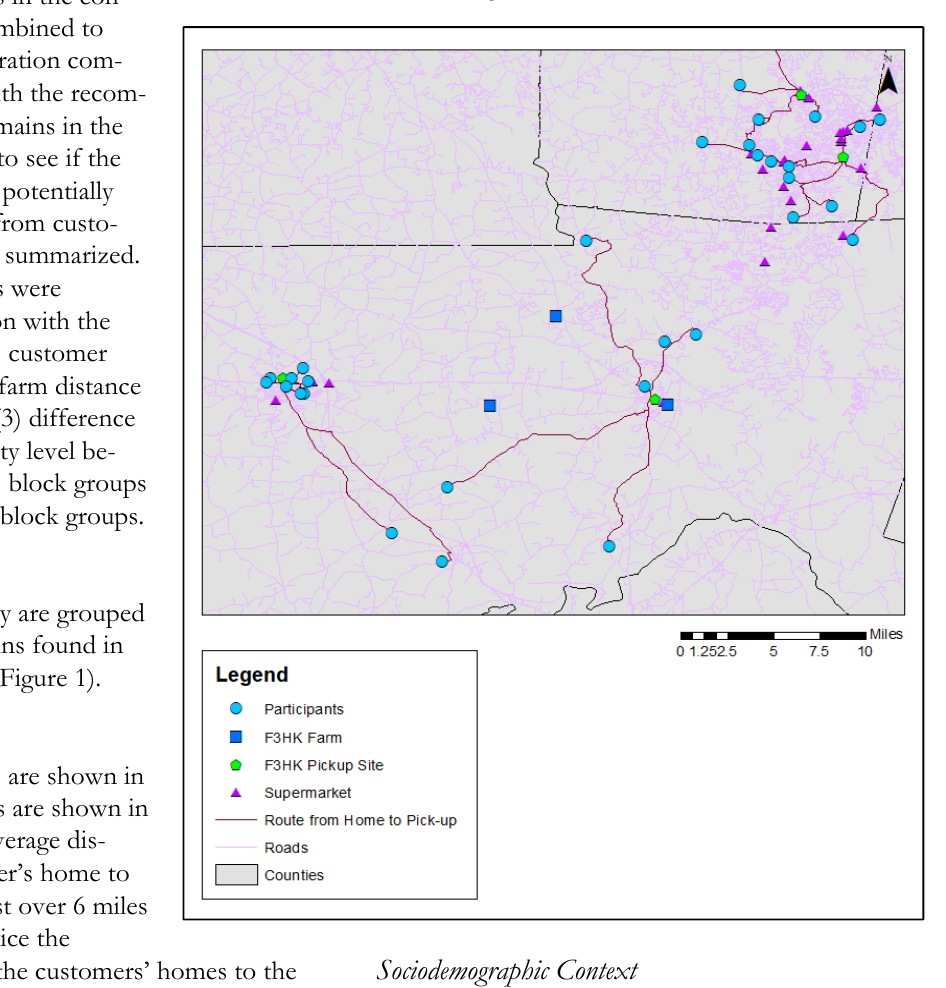
Figure 2. Map of GIS Road Network Analysis between Participant Addresses, Pickups Sites, Farmer Addresses, and Retail Food Stores at North Carolina Project